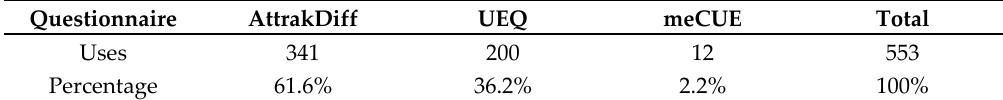
Table 2. Total number of uses of standardized questionnaires